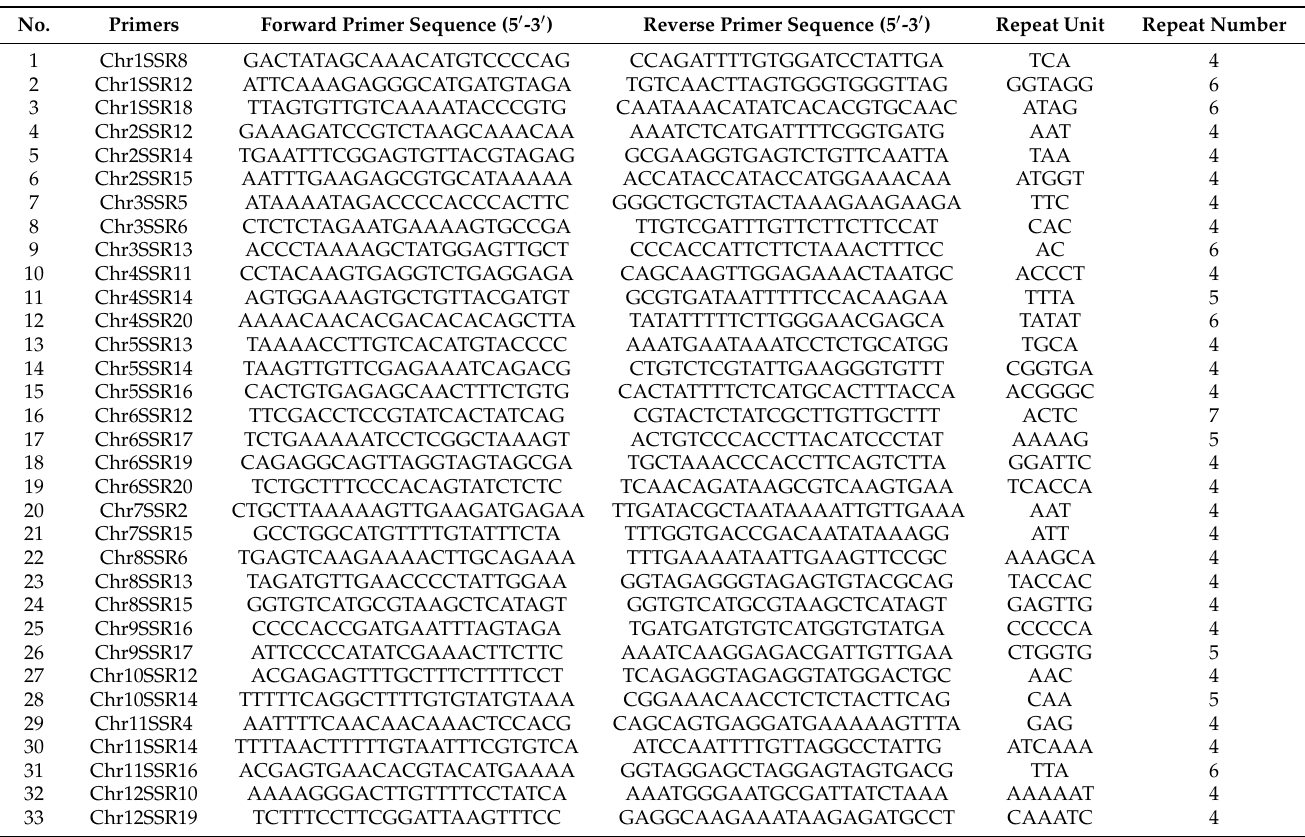
Table 1. Details of 33 SSR primers used in the